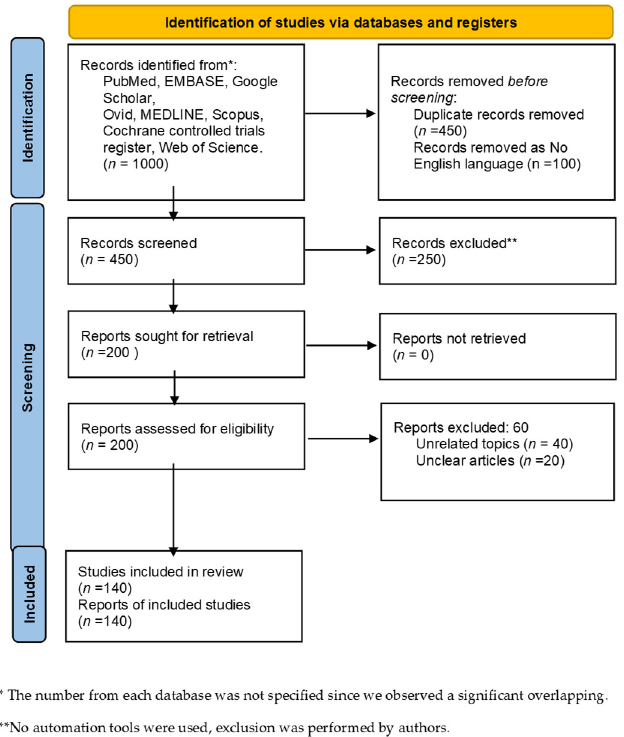
Figure 1. PRISMA flow diagram.